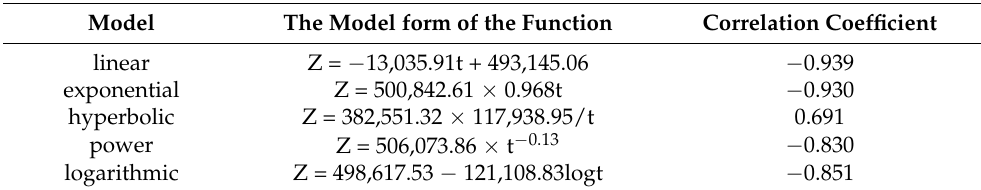
Table 7. A summary of the regression analysis results for the domestic coal sales (“Indv. con- sumers 1”).